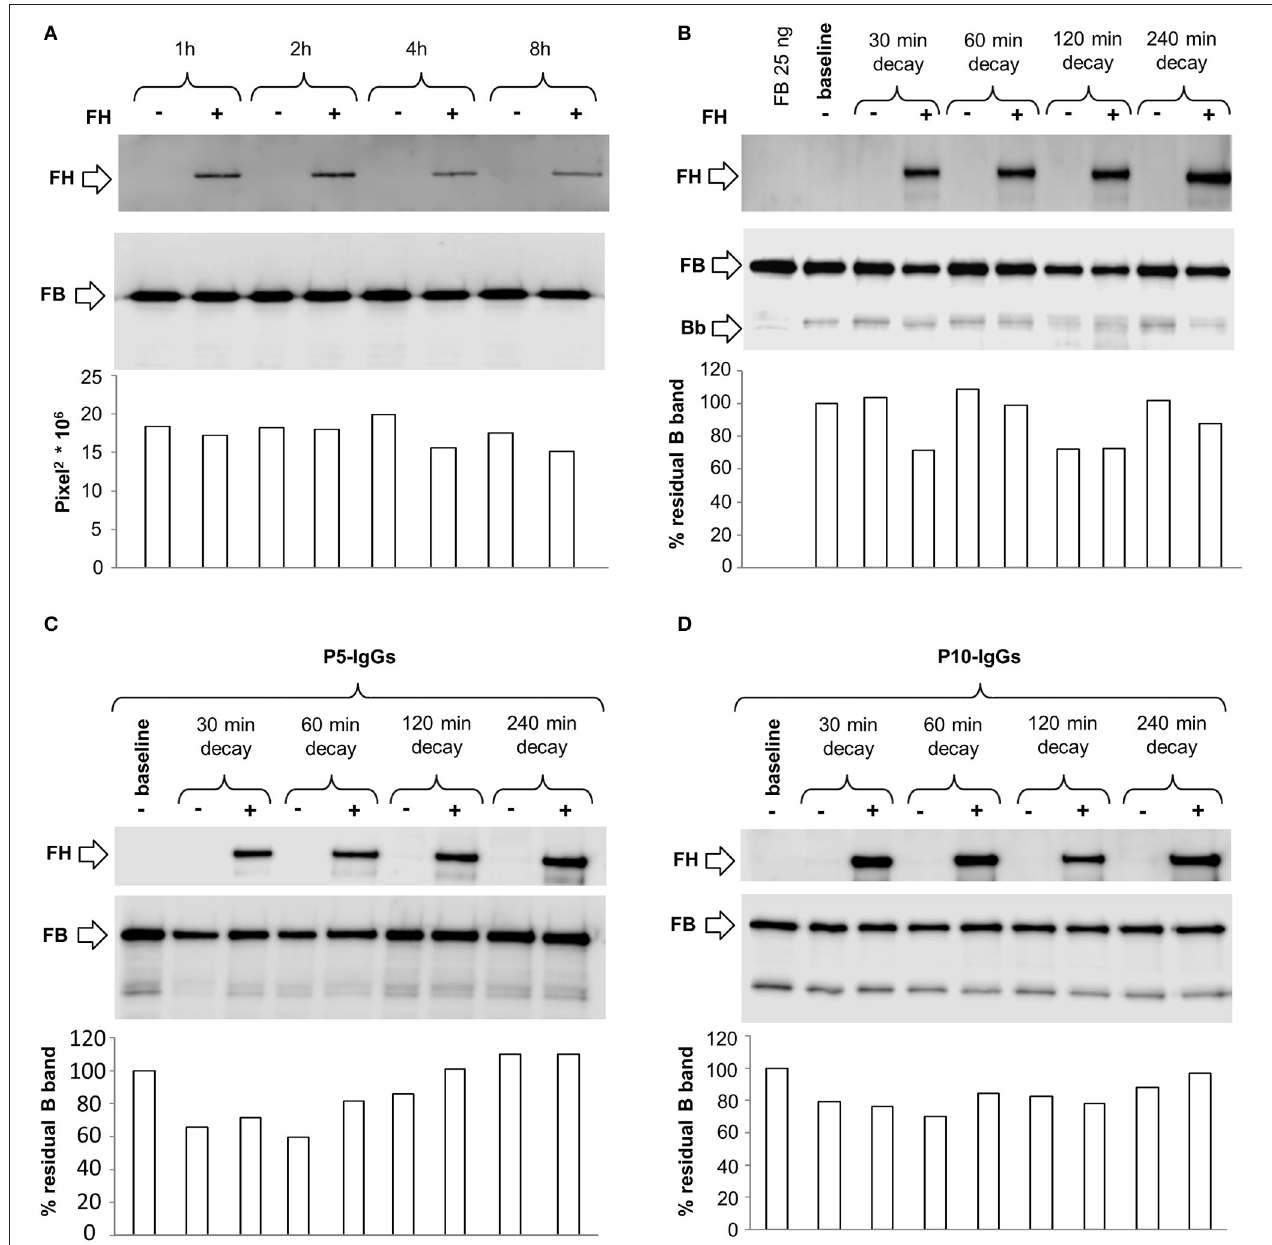
FIGURE 9 | Formation and decay of C3bB(Mn 2 + ) C3 proconvertase in the absence or in the presence of C3NeF IgGs, by microplate/WB assay. (A) Time course of C3bB(Mn 2 + ) C3 proconvertase formation. The complexes were obtained incubating C3b-coated wells at 37 ◦ C for 1, 2, 4, and 8h with 1,000ng/ml FB and 2mM MnCl 2 in the absence (-) or in the presence ( + ) of 2,640ng/ml FH. The amount of C3bB formed was calculated as the density of B band (93 KDa), and reported in the bottom graph as Pixel 2 * 10 6 . (B–D) Time course of C3bB(Mn 2 + ) C3 proconvertase spontaneous and FH-mediated decay. C3bB(Mn 2 + ) complexes formed in 2h at 37 ◦ C in the absence (B) or in the presence of C3NeF IgGs purified from patients P5 (C) and P10 (D) , were further incubated with buffer alone (decay –) or with buffer added with 2,640ng/ml FH (decay + ), respectively, for 30, 60, 120, and 240min at 37 ◦ C The percentage of residual B band was calculated as the ratio of the densities (in Pixel 2 ) of each B band after decay and the corresponding baseline B band density before decay x 100 and results are reported in the bottom graphs. The membranes were then incubated with an anti-FH antibody and FH band could be visualized at 150 KDa (top). Results of a representative microplate/WB experiment of n = 3 are